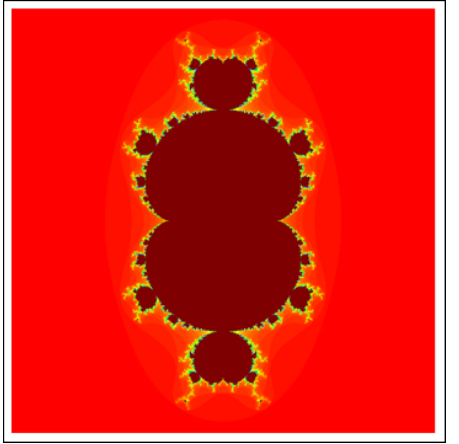
Figure 33. Third degree M-set via F-iteration with image visual time = 81.39 s.